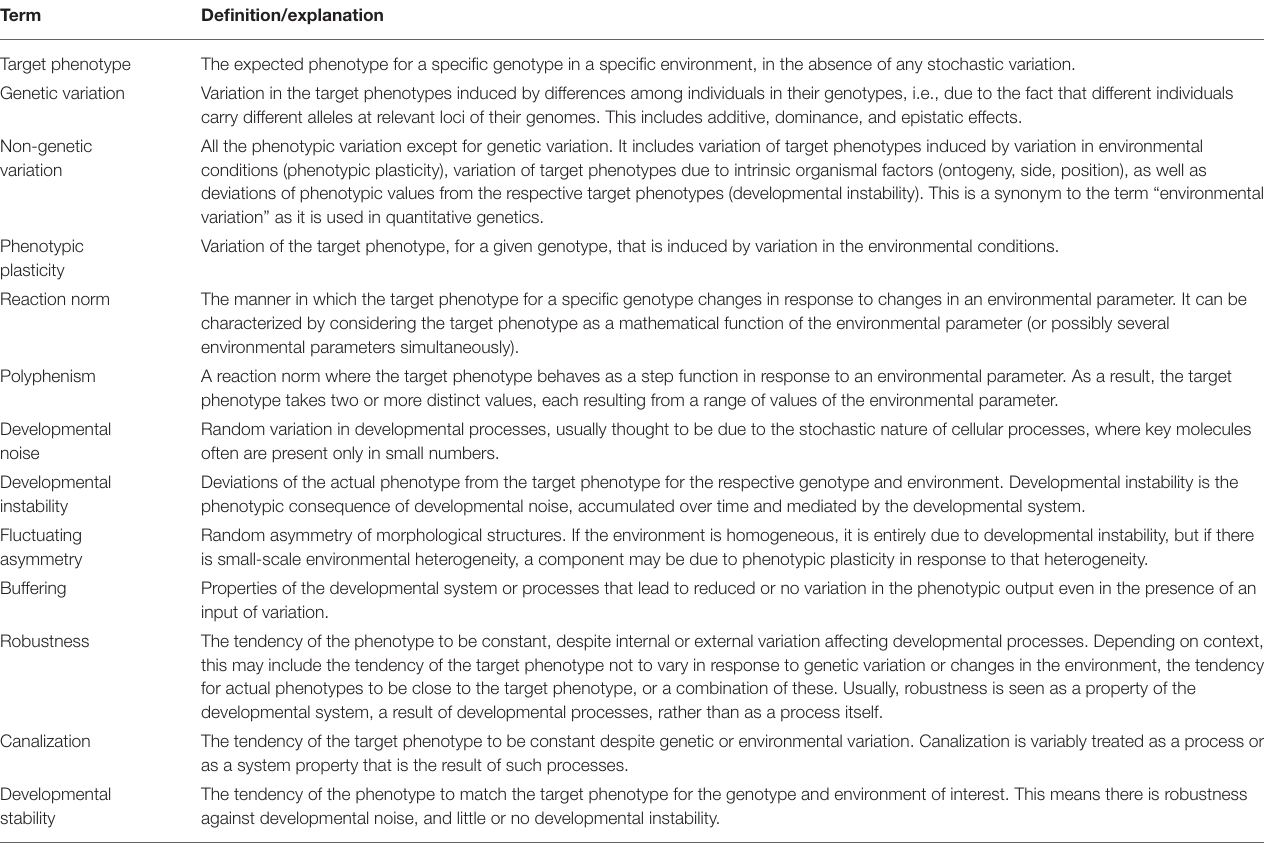
TABLE 1 | Key terms used in this paper and their